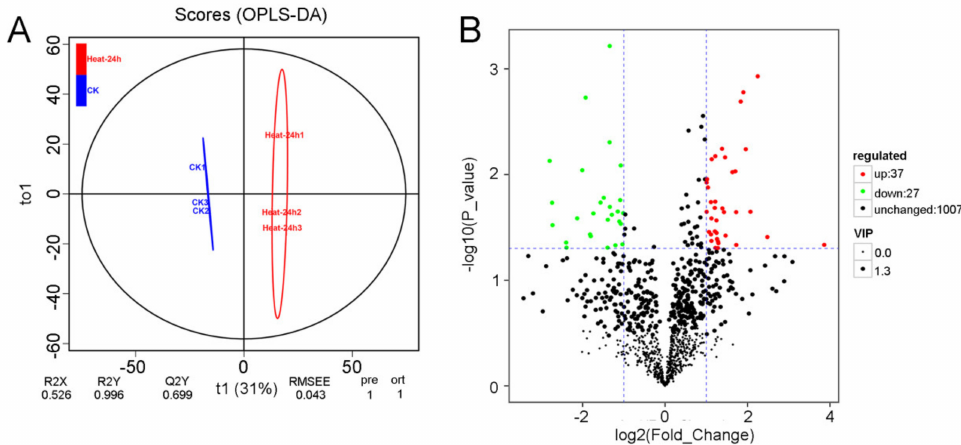
Figure 5. Identification of differentially accumulated metabolites. ( A ) Metabolic analysis using an OPLS-DA model. ( B ) Volcano plots of differentially accumulated metabolites under HS compared with the control group. The green indicates downregulated metabolites, red indicates upregulated metabolites, and black indicates no significant